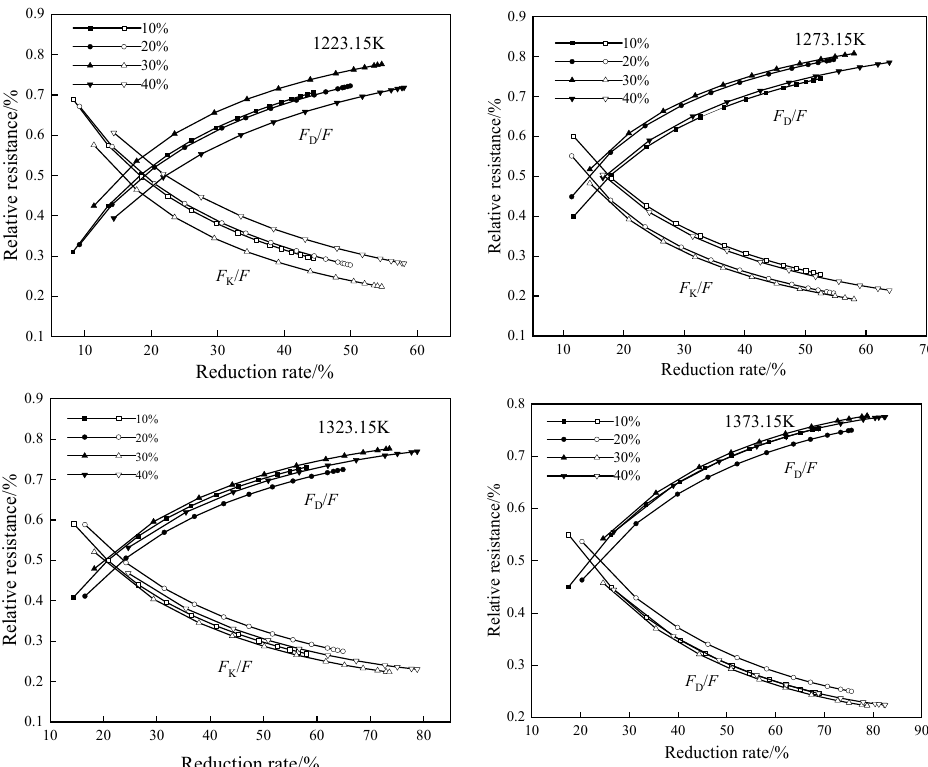
Figure 13. Relationship between the relative resistance and reduction.